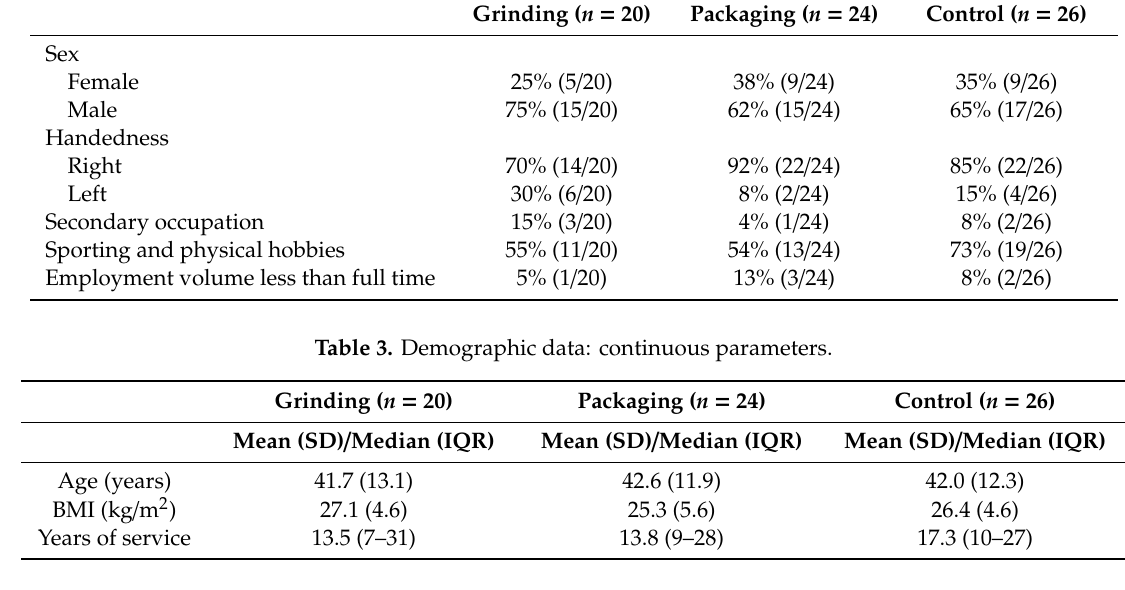
Table 2. Demographic data: categorical parameters.